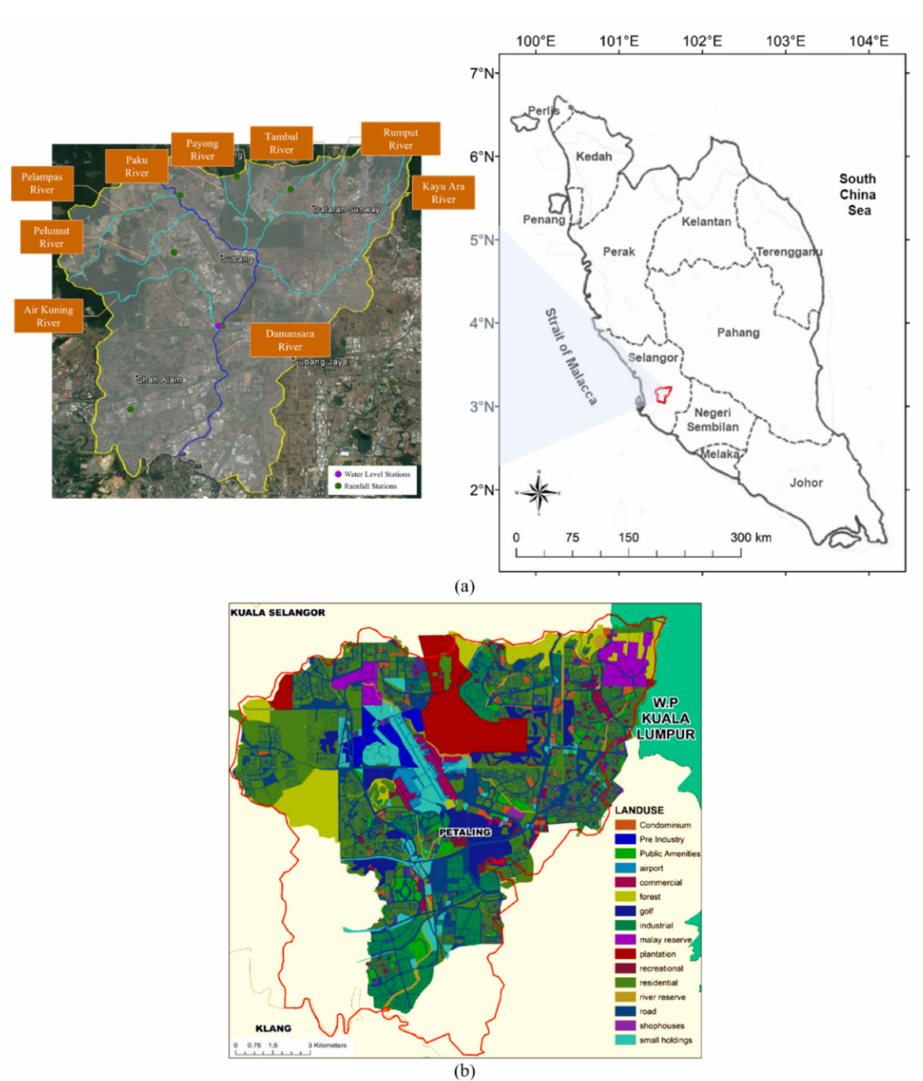
Figure 1. ( a ) Location of Damansara catchment; ( b ) distribution of land use in Damansara